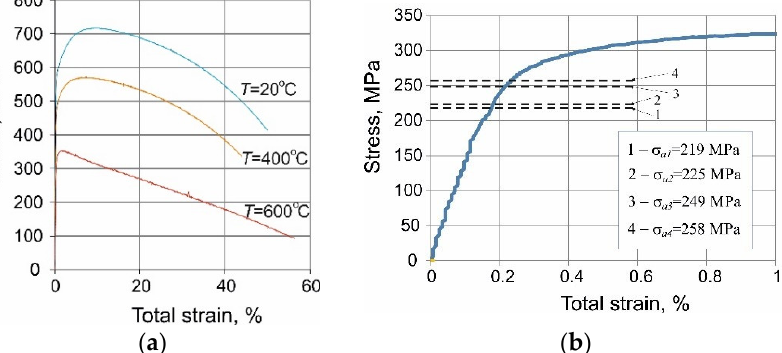
Figure 4. Monotonic stress–strain curves: ( a ) for different test temperatures, ( b ) stress amplitude levels chosen for creep-fatigue tests ( T = 600 ° C).